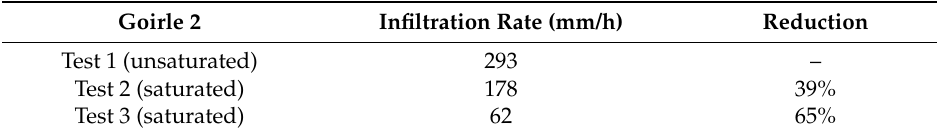
Table 3. Comparison of three FSIT tests at the Goirle 2